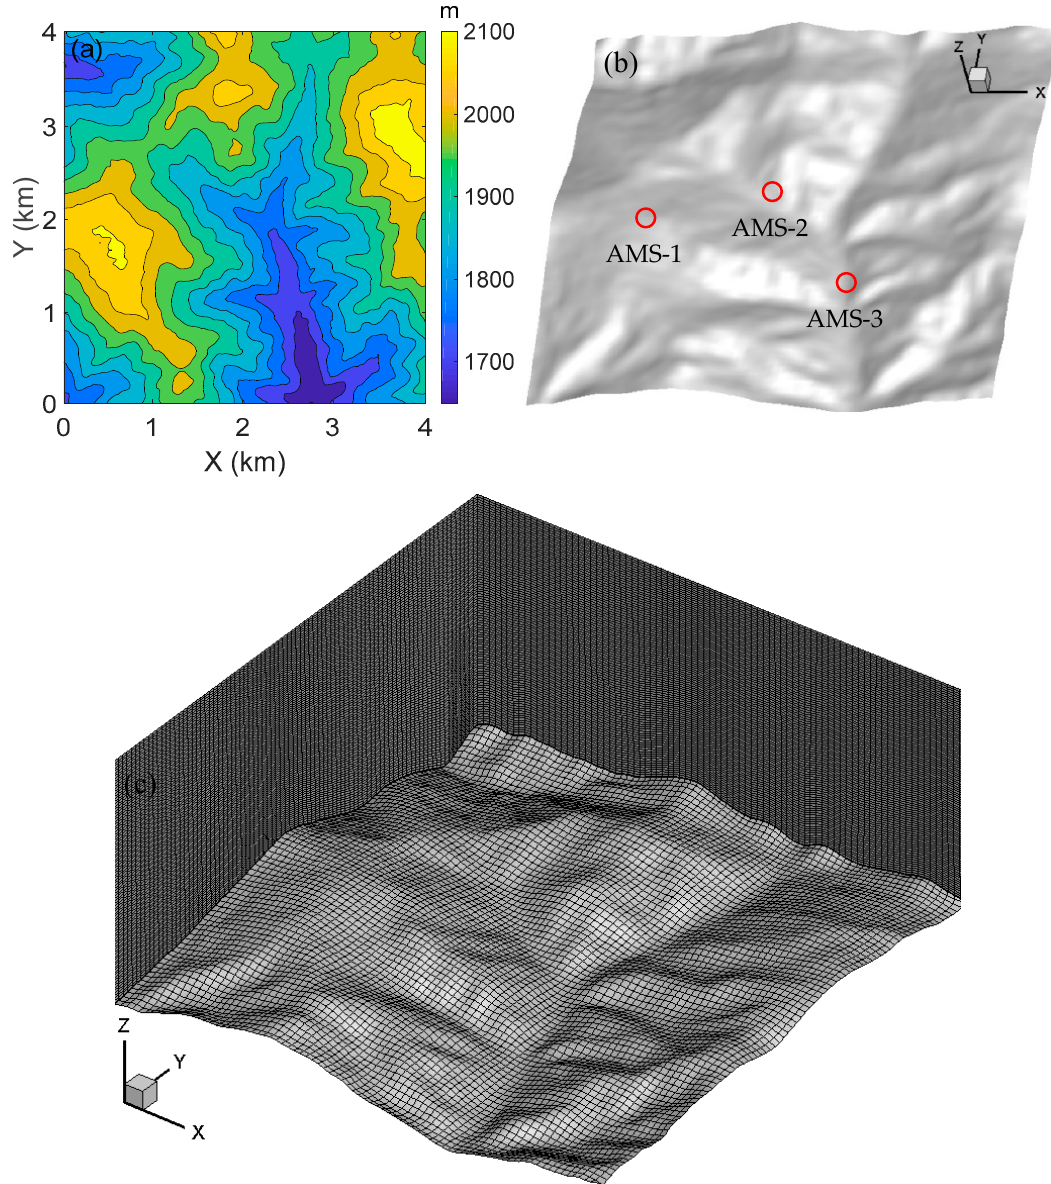
Figure 2. The sketch map of the CFD simulation configuration: ( a ) terrain height of the CFD domain; ( b ) 3D terrain modeling of the CFD domain, the red dots indicate the locations of the automatic meteorological stations (AMS); ( c ) the body-fitted hexahedral grid system used in the CFD domain.